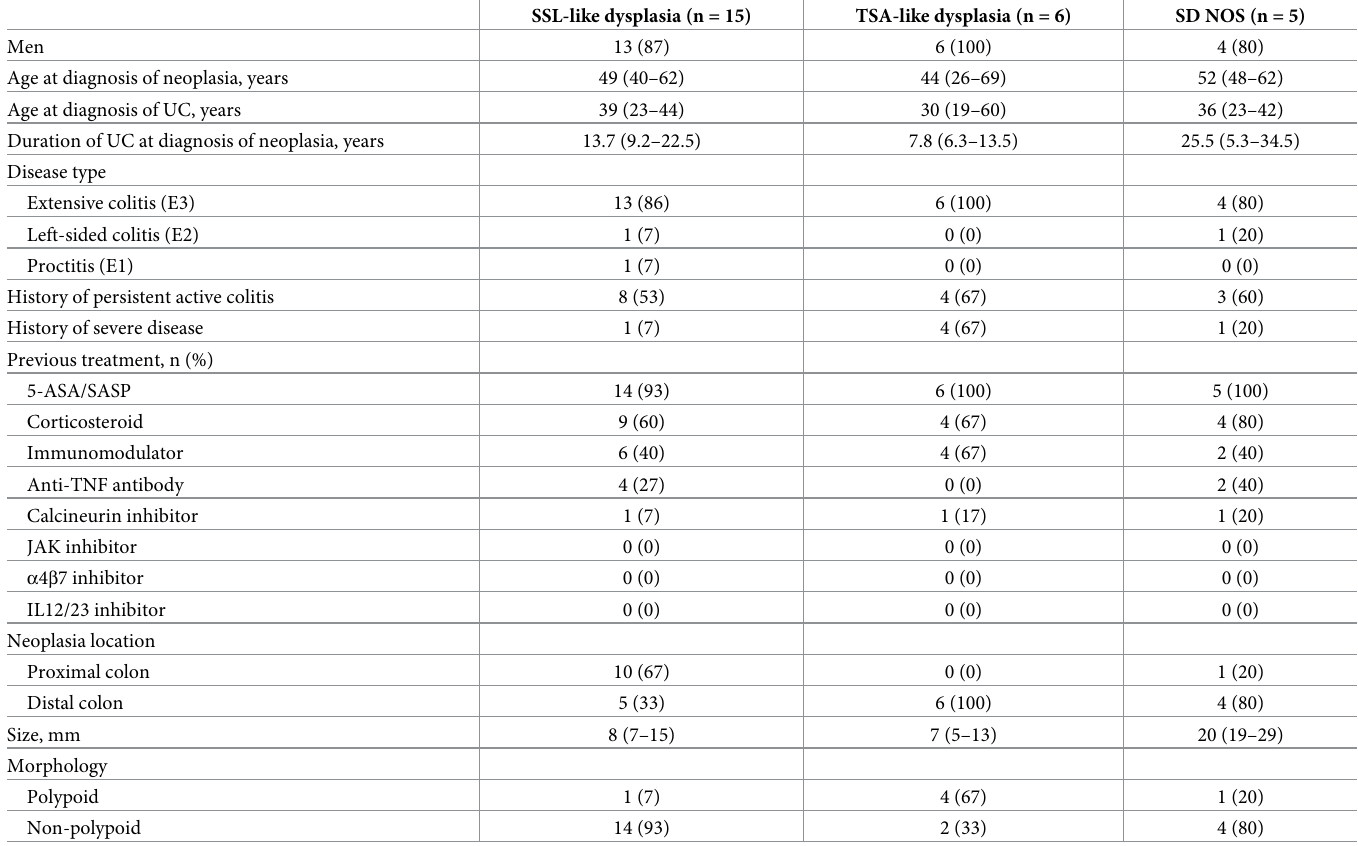
Table 3. Clinical characteristics of each subtype of serrated polyp in colitis-affected segments.